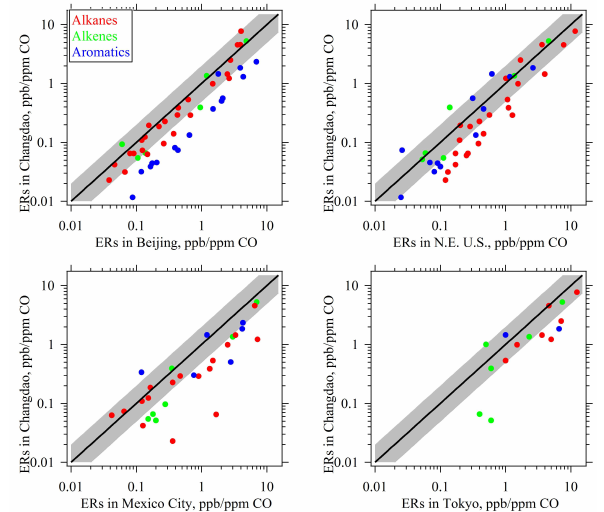
Fig. 3. Comparison of emission ratios of NMHCs to CO determined at Changdao with those obtained in Beijing (Yuan et al., 2012), the northeastern US (Warneke et al., 2007), Mexico City (Bon et al., 2011) and Tokyo (Shirai et al., 2007). The black lines indicate the 1 : 1 relationship, and the gray areas show agreements within a factor of